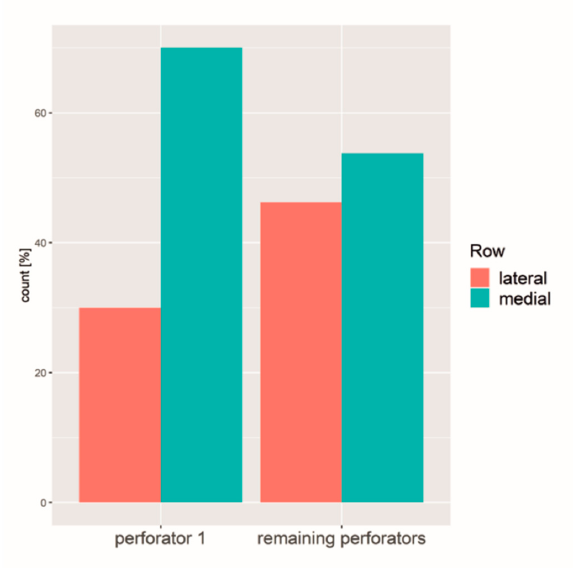
Figure 7. Distribution of the largest perforator versus the remaining perforators regarding the branch of the DIEA.